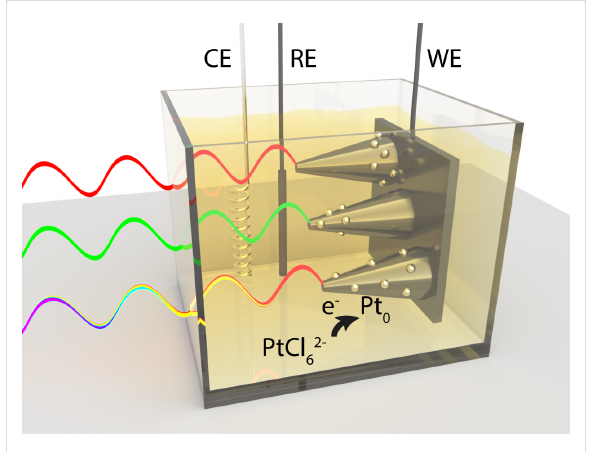
Figure 1: Schematic illustration of the photo-electrochemical deposi- tion of metallic Pt on silicon nanostructures from hexachloroplatinate (PtCl 62 − ) in a three-electrode photo-electrochemical cell with counter electrode (CE), reference electrode (RE) and working electrode (WE). The location of catalyst deposition can be tuned by adjusting the exci- tation wavelength from red to green to white, or (not shown) the nano- structure